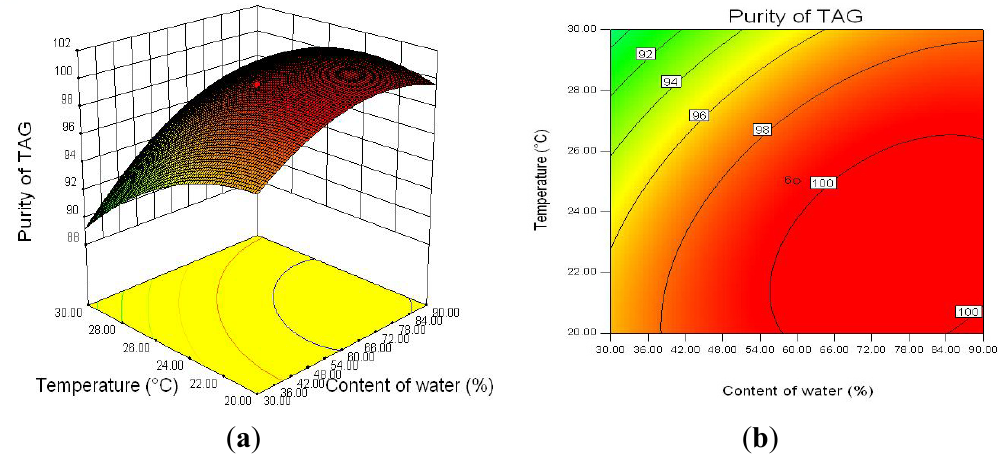
Figure 3. Response surface plot ( a ) and its contour plot ( b ) of the TAG purity; temperature vs. water content with a constant level of pH (pH = 5).